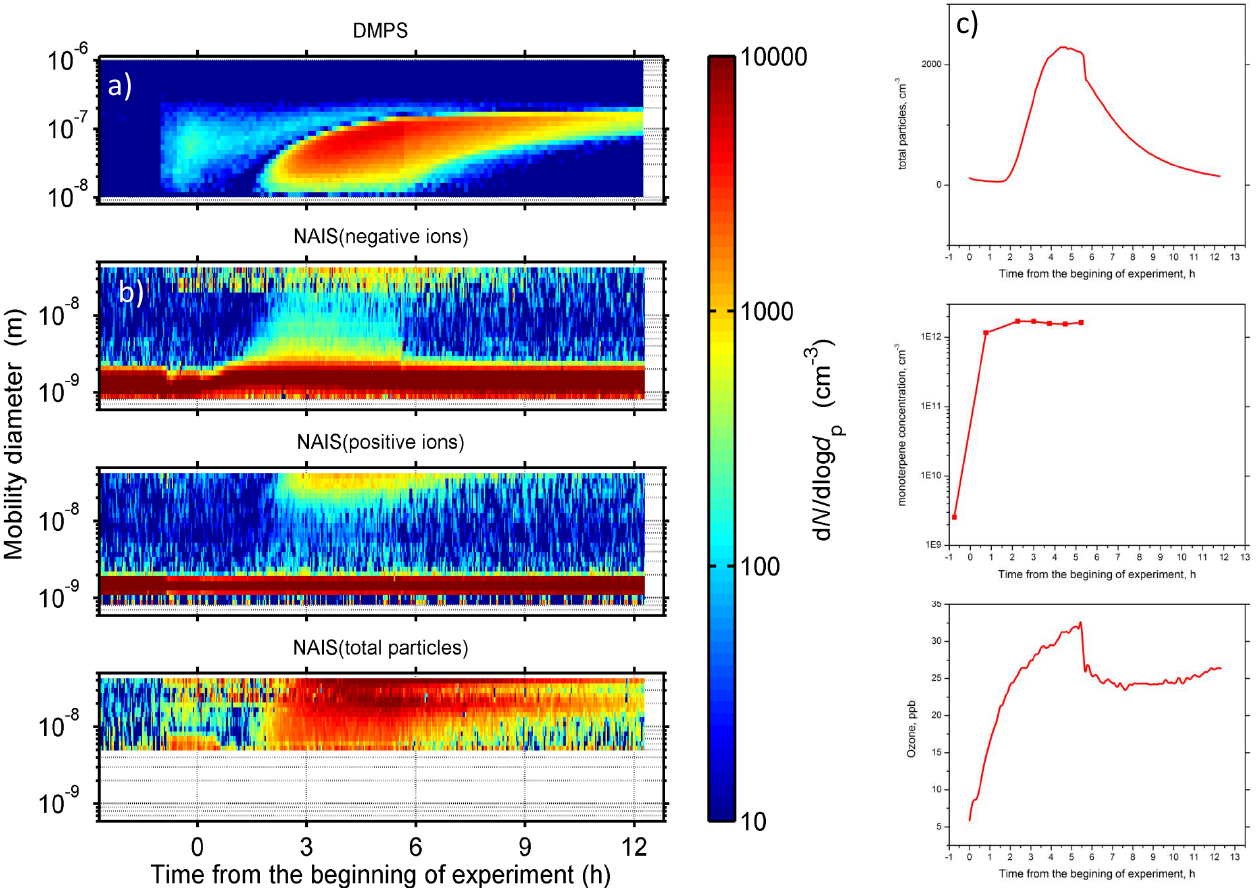
Fig. 3. 1 3 -carene event on 12 November 2008. (a) a DMPS plot showing all particles (neutrals + charged) from 10 to 1000nm. (b) a NAIS plot showing particles from 0.8 to 40nm. Top: negative particles; middle: positive particles; bottom: neutral + charged particles. (c) Top: total number of particles percm 3 , middle: Ozone concentration in ppb , bottom: 1 3 -carene concentration per cm 3